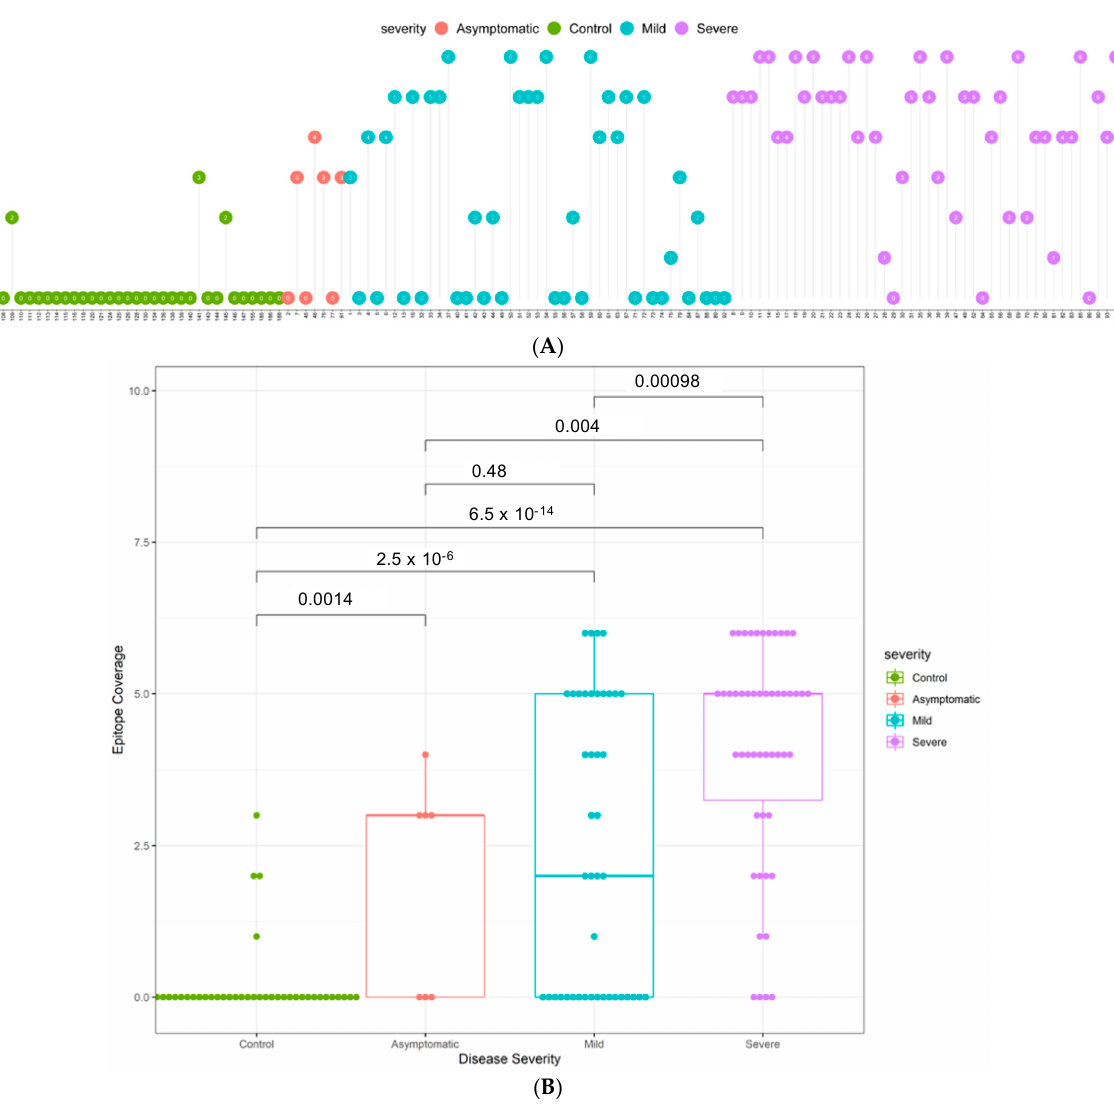
Figure 2. Epitope coverage in multi-ethnic Cohort 3. ( A ) Epitope coverage for each sample for controls, mild cases, and severe cases ( n = 138). Numbers in dots represent the EPC score per participant. ( B ) Box plots displaying the epitope coverage for each disease class. p -values were determined using the Wilcoxon test (unpaired, two-tailed).